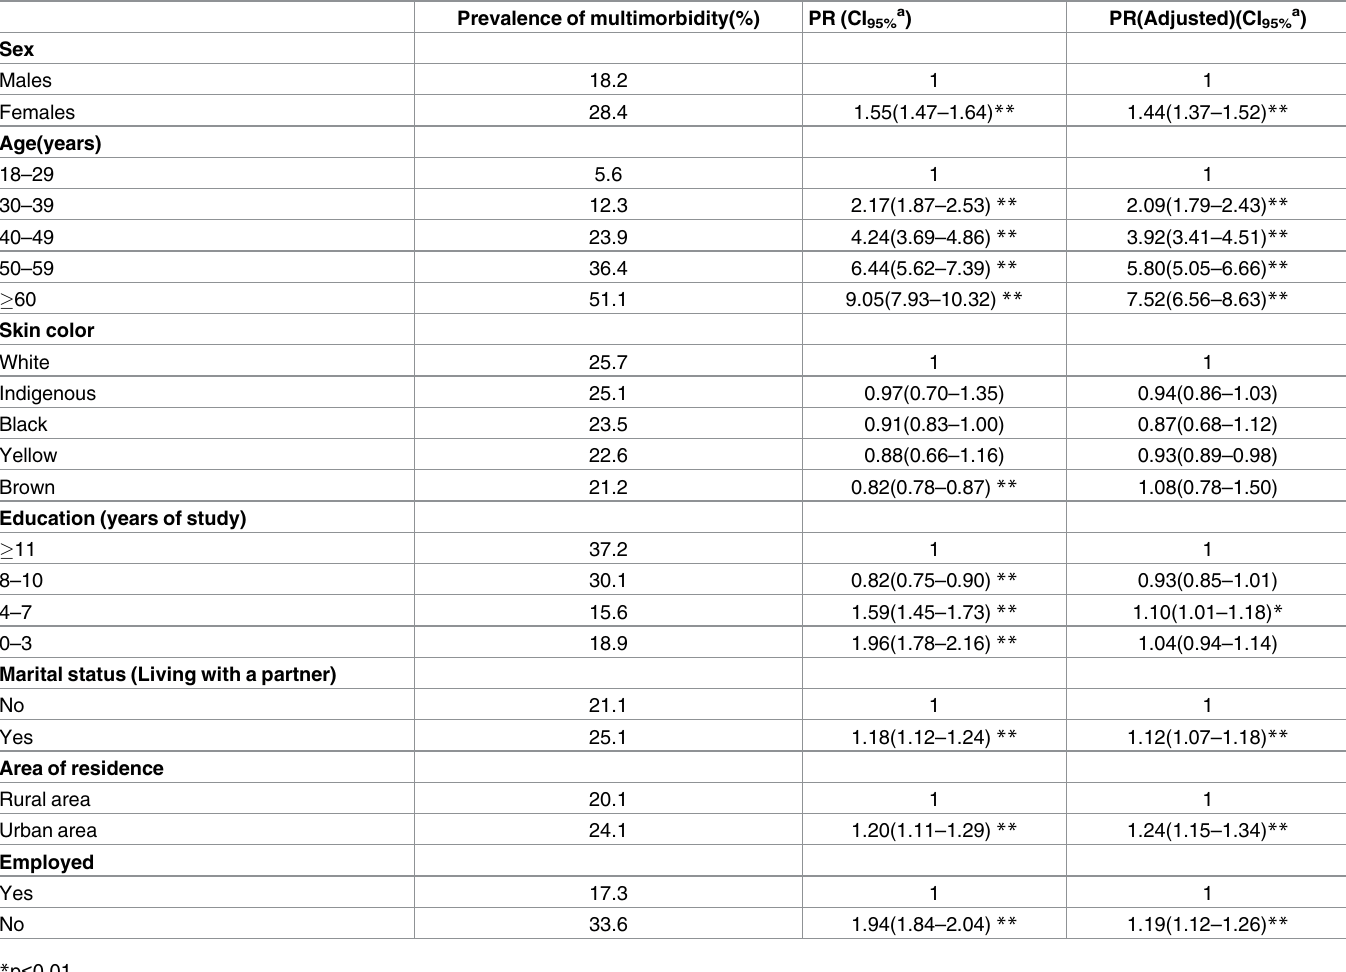
Table 4. Univariate and multivariate analysis of the association between sociodemographic characteristics and multimorbidity. NHS, Brazil,